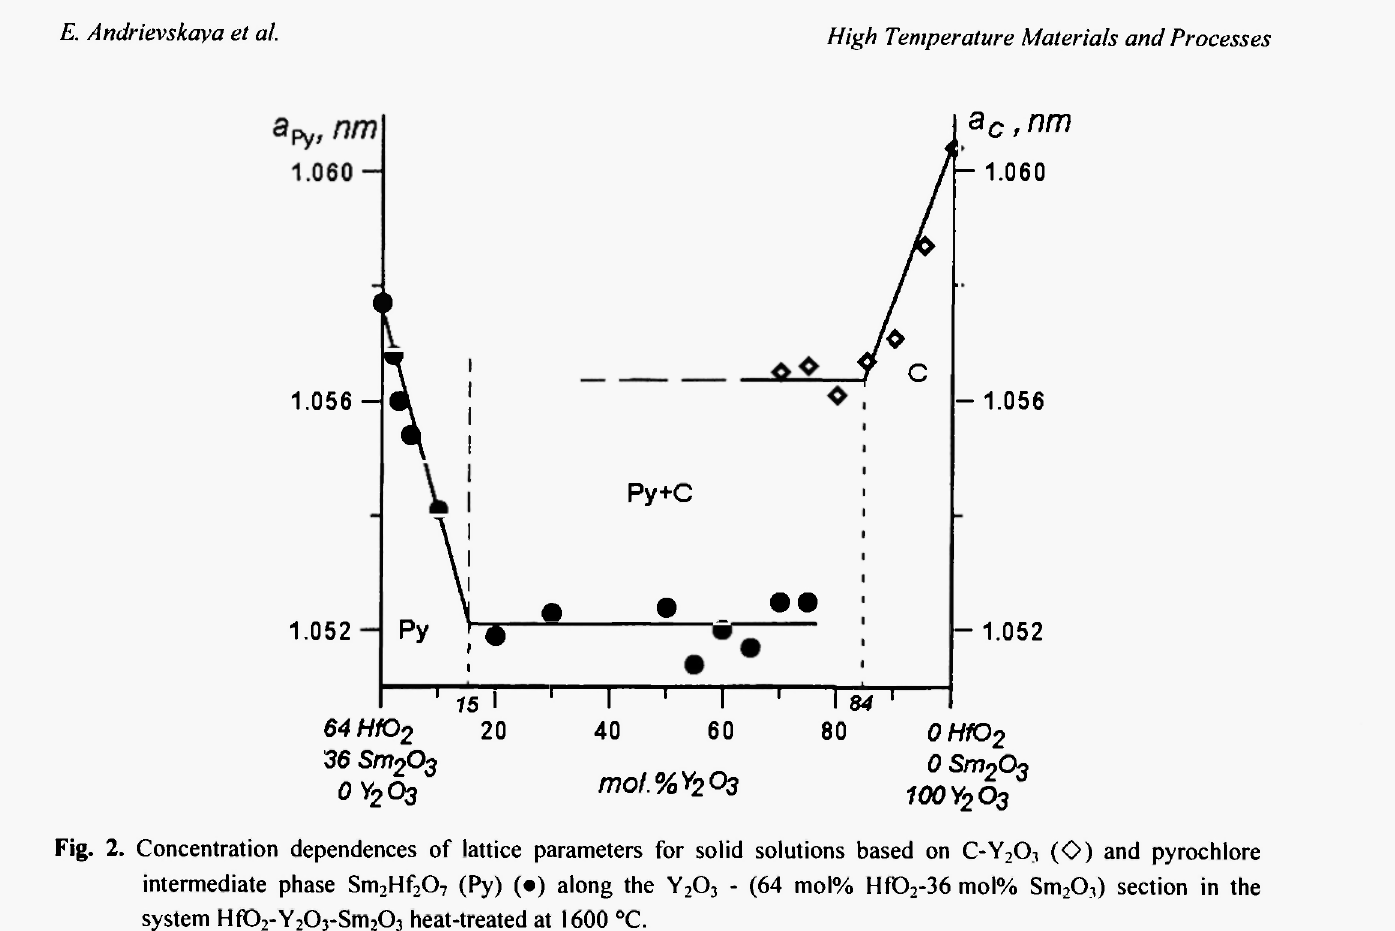
Fig. 2. Concentration dependences of lattice parameters for solid solutions based on C-Y 2 0 3 ( O) and pyrochlore intermediate phase Sm 2 Hf 2 07 (Py) ( ·) along the Y 2 0 3 - (64 mol% HfO 2 -36 mol% Sm 2 0 3 ) section in the system Hf0 2 -Y 2 0 3 -Sm 2 0 3 heat-treated at 1600